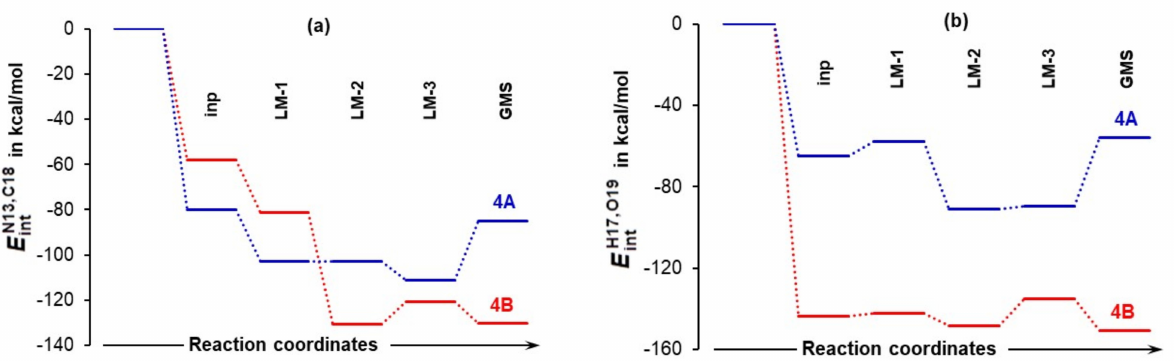
Figure 11. Intermolecular interaction energies computed for the N13,C18 (part ( a )) and H17,O19 (part ( b )) atom-pairs in the indicated